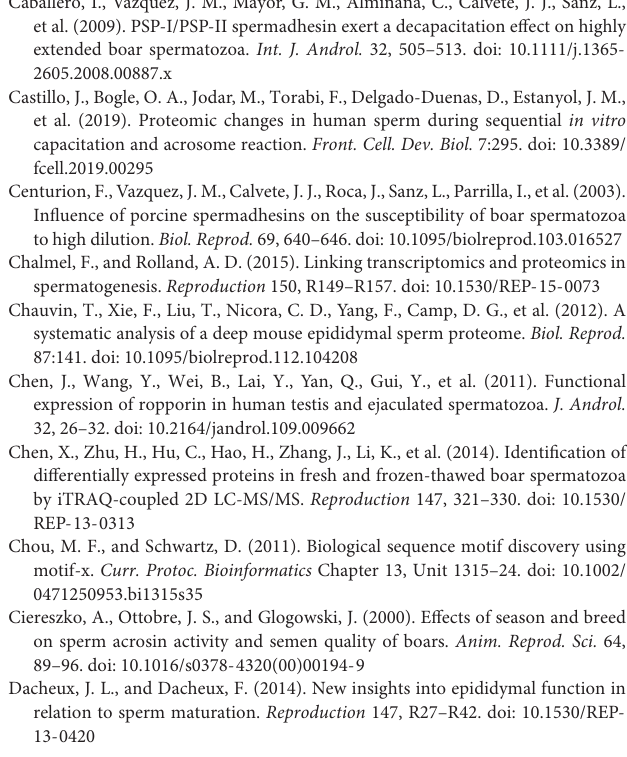
Supplementary Figure 1 | Map of AKAP4 phosphorylation sites identified from porcine boar Spermatozoa. The down-regulated phosphorylated sites are represented in green while the up-regulated ones are colorized in red. Black box represents the phosphorylation motif. Supplementary Figure 2 | GO enrichment analysis of the total identified porcine boar sperm proteins. (A) GO cellular compartments categories; (B) GO biological process categories; (C) GO molecular functions. Supplementary Figure 3 | Western blot result of the selected